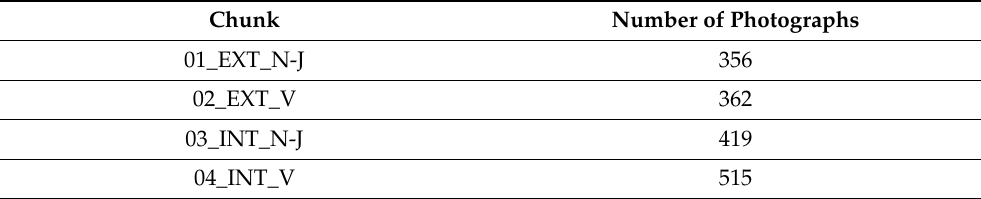
Table 2. Number of photographs taken for the generation of partial point clouds of buildings. Chunk